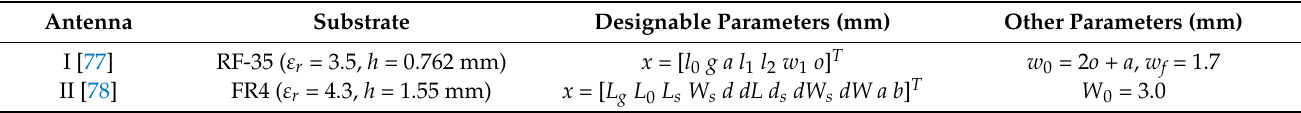
Figure 5. Benchmark monopole antennas: ( a ) Antenna I, ( b ) Antenna II. The feeding line and the radiator marked using the dark gray shade; ground plane marked using light gray shade. Table 1. Benchmark Monopole Antennas.